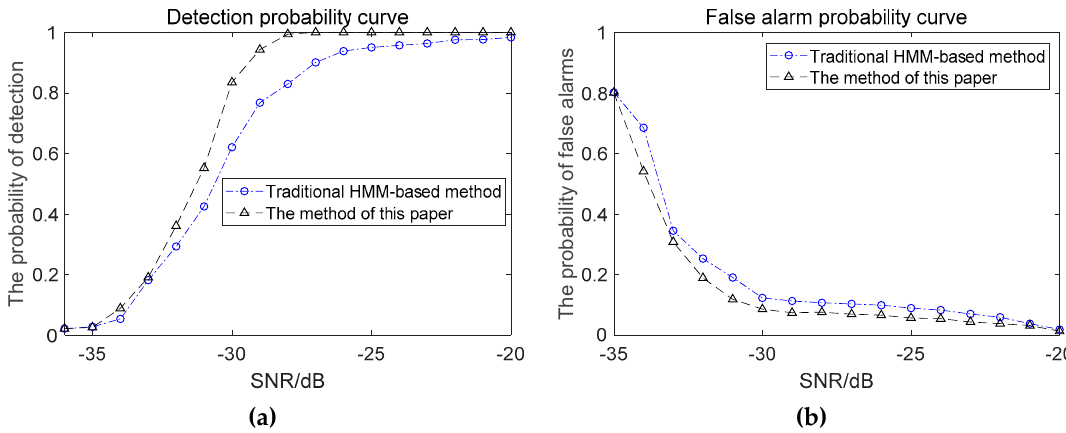
Figure 19. Performance Comparison of the proposed method in this paper and traditional HMM-based method between different method: (a) The detection probability curve; (b) The false alarm probability curve.